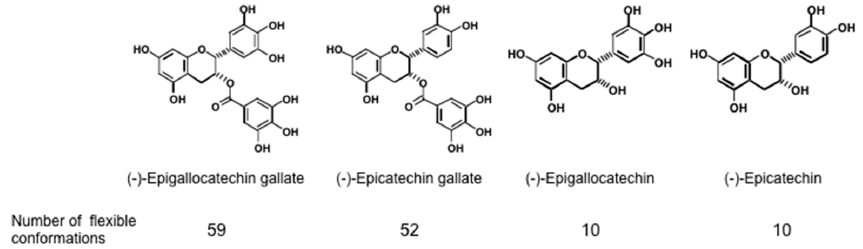
Figure 1. Structures of four green tea catechins and number of their flexible conformations.